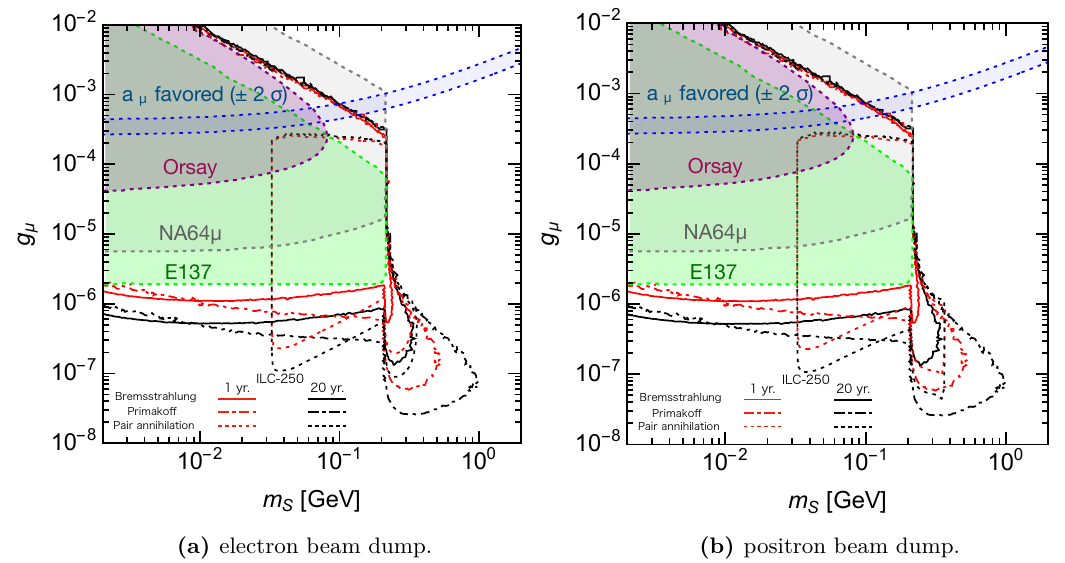
Figure 8. The red and black curves show the perspectives of sensitivity for ILC-250 at 95% C.L. with 1- and 20-year statistics. The solid lines are for the bremsstrahlung process, the dash-dotted lines are for the Primakoff process, and the dotted lines are for the pair annihilation of positrons. The shaded blue region is a constraint from muon g − 2 and the shaded gray region is a perspective of a sensitivity of the NA64 µ